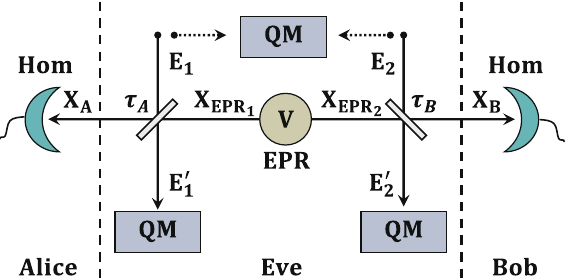
Figure 1. Schematic of the entanglement-in-the-middle CV-QKD protocol 34 . EPR: untrusted two-mode squeezed state with variance V . Hom: homodyne detection. QM: quantum memory. Only the homodye detections are discussed here and Eve’s attacks are considered as two correlated modes attacks without loss of